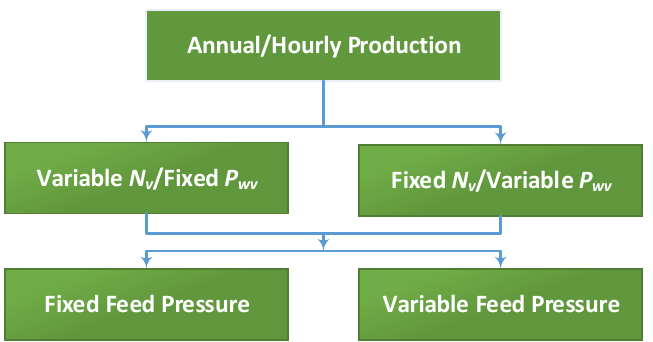
Figure 5. Different design scenarios based on different options for the design variables.